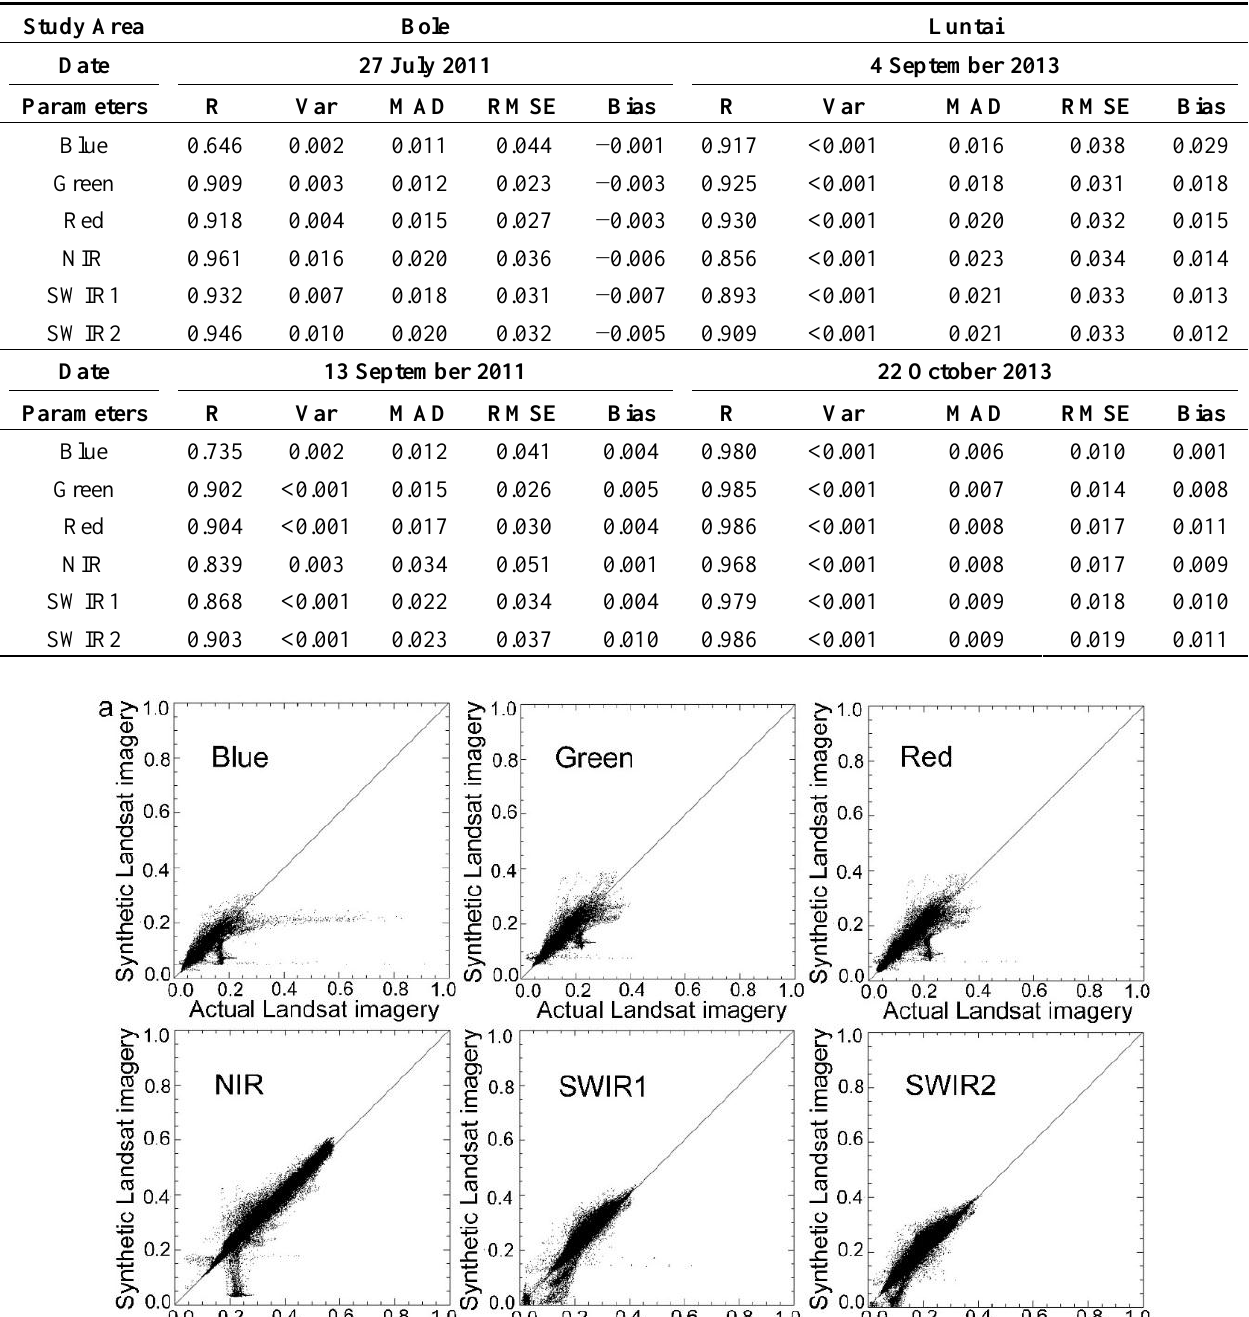
Table 5. Results of correlation analysis between synthetic and actual Landsat imageries. Study Area